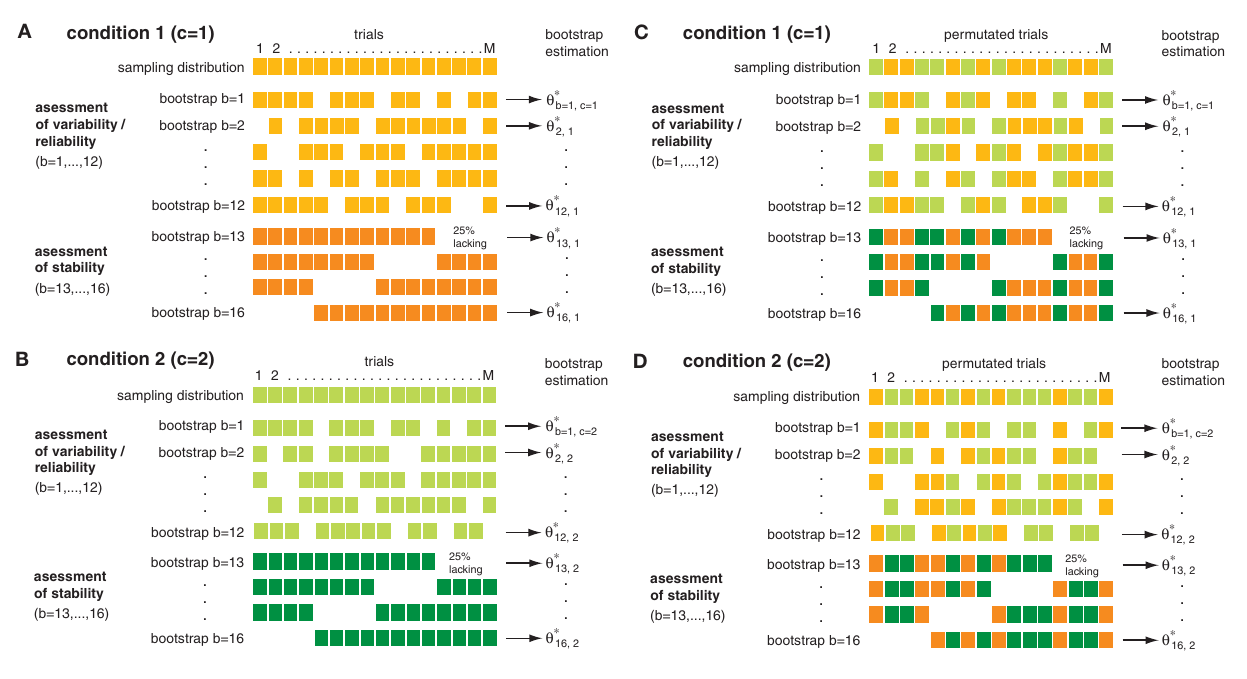
FIGURE 1 | Permutation and n-jackknife test for bivariate testing of performance-related changes. The example illustrates the concept of the testing procedure. Bootstrapping and n-jackknife of two-samples [ (A) : sample 1, (B) : sample 2] from two conditions [ (C) condition 1, (D) condition 2] were used. These data were sub sampled based on a combination of an n-jackknife and bootstrapping. The bootstrapping generates 12 bootstrap samples which contain random 75% of the trails and were used to determine variability in each data set